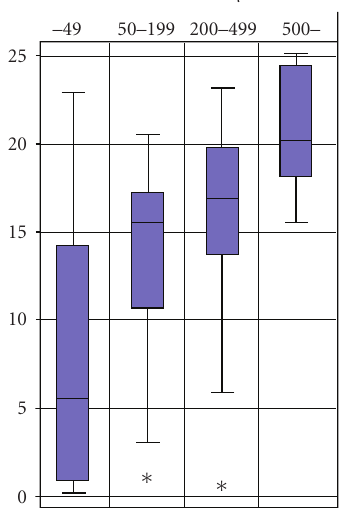
Figure 1: Box plot of the interferon-gamma response to mitogen according to the CD4 + T cell count level. ∗ indicates an